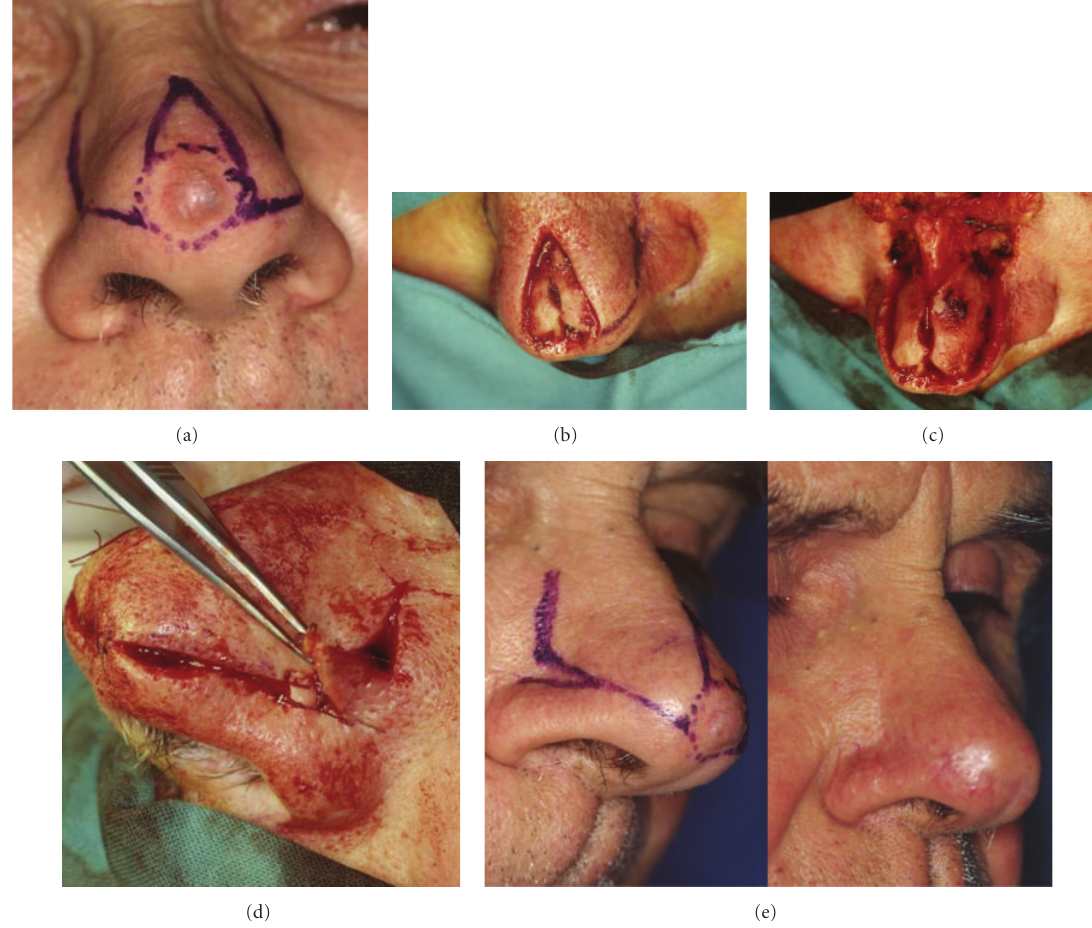
Figure 1: (a) BCC involving nasal tip: flap design. (b) Tumour resection. (c) Intraoperative view: modified bilateral nasalis flap. (d) Interpositional flap from the alar groove. (e) Nasal appearance before and one year after